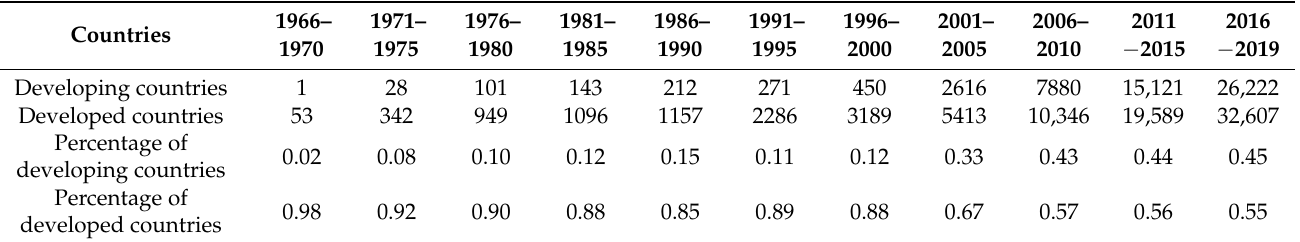
Table 3. Comparison of planning research investment from developed and developing countries since 1966